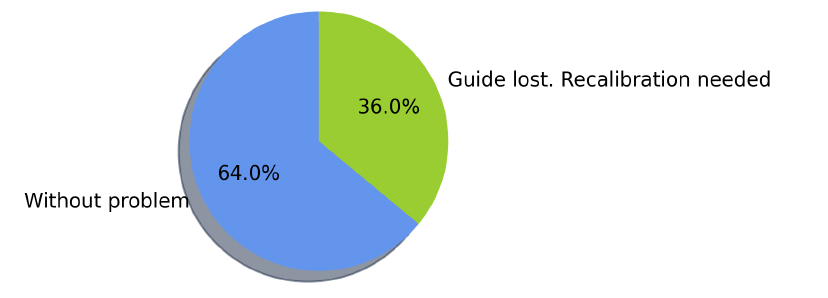
Figure 14. AR line display errors during navigation.